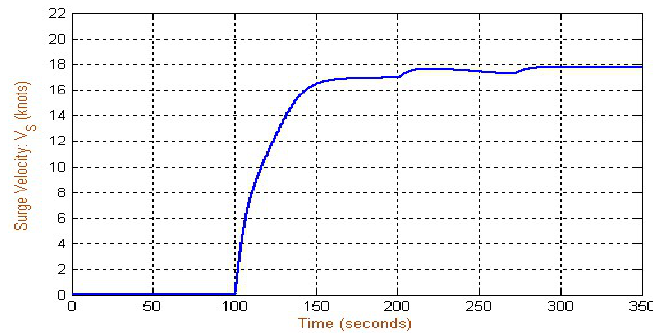
Figure 23. Speed versus